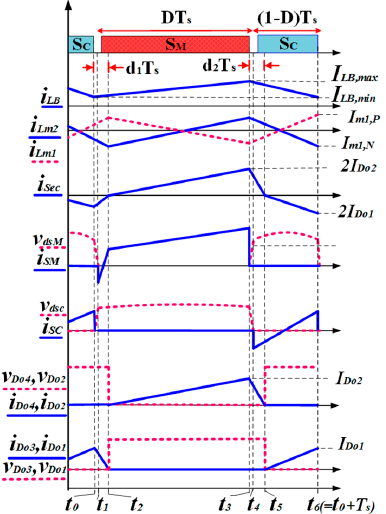
Figure 4. Key waveforms of the proposed converter.